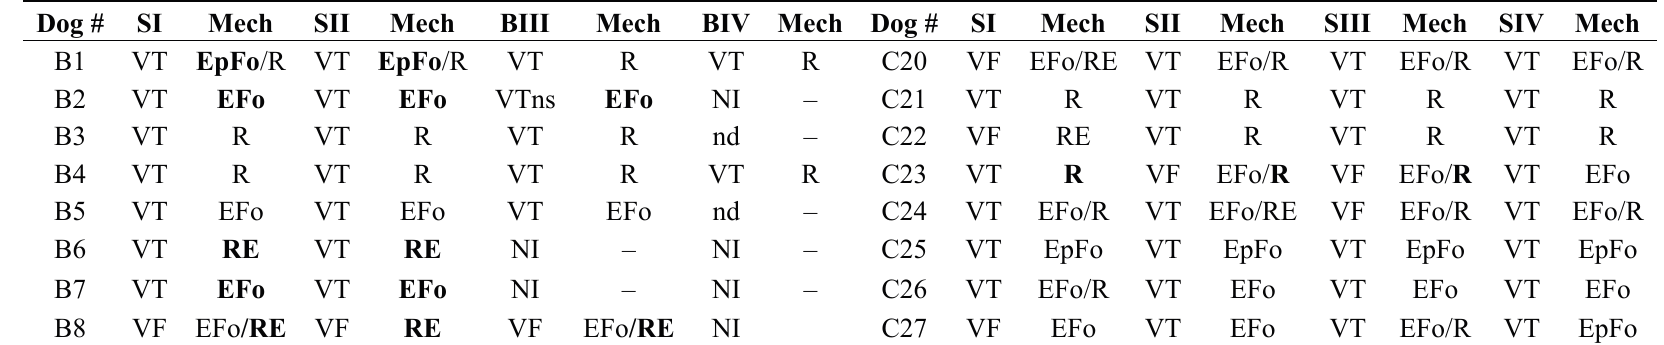
Table 4. BOTH (APO and OXY) group